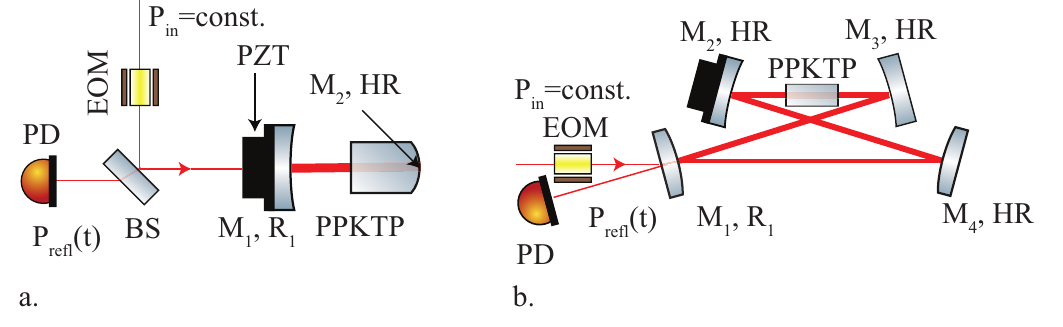
Figure 3. ( a ) half-monolithic cavity setup for the absorption measurement at 775 nm: Mirror M 1 and the HR coating on the PPKTP crystal’s curved end surface formed the cavity. The length of the cavity was scanned with the PZT onto which M 1 was mounted. A photo diode (PD) detected resonance peaks P refl (t) in reflection of M 1 ; ( b ) Bow-tie cavity setup for the absorption measurement at 1,550 nm: The in-coupling mirror M 1 and three HR-coated mirrors formed a bow-tie ring-cavity. The PPKTP crystal was placed within the small waist between the concave mirrors M 2 and M 3 . M 2 was moved by a PZT. The PD detected the resonance peak P refl (t) in reflection of M 1 . In both setups the beam passed an EOM for imprinting sidebands before entering the cavity for the calibration of the mirror